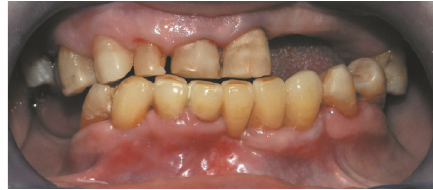
Figure 4: The final phase of prosthetic